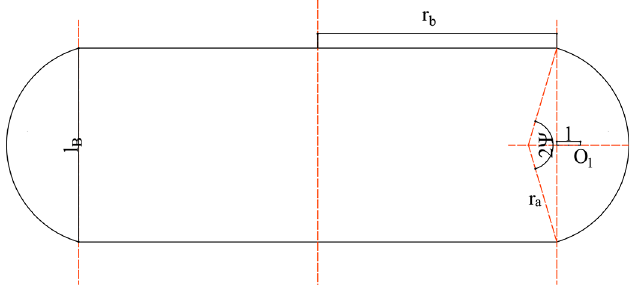
Fig. 10. Approximate geometry of single air chamber